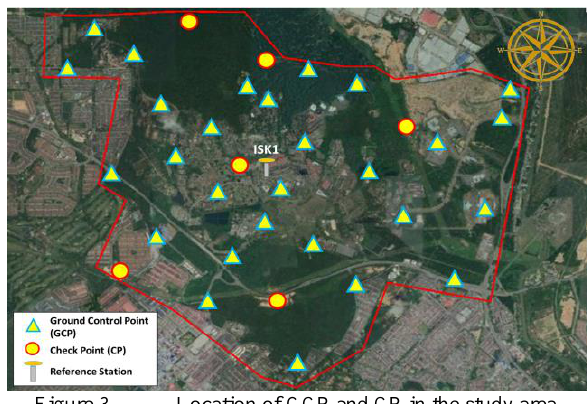
Figure 3 Location of GCP and CP in the study